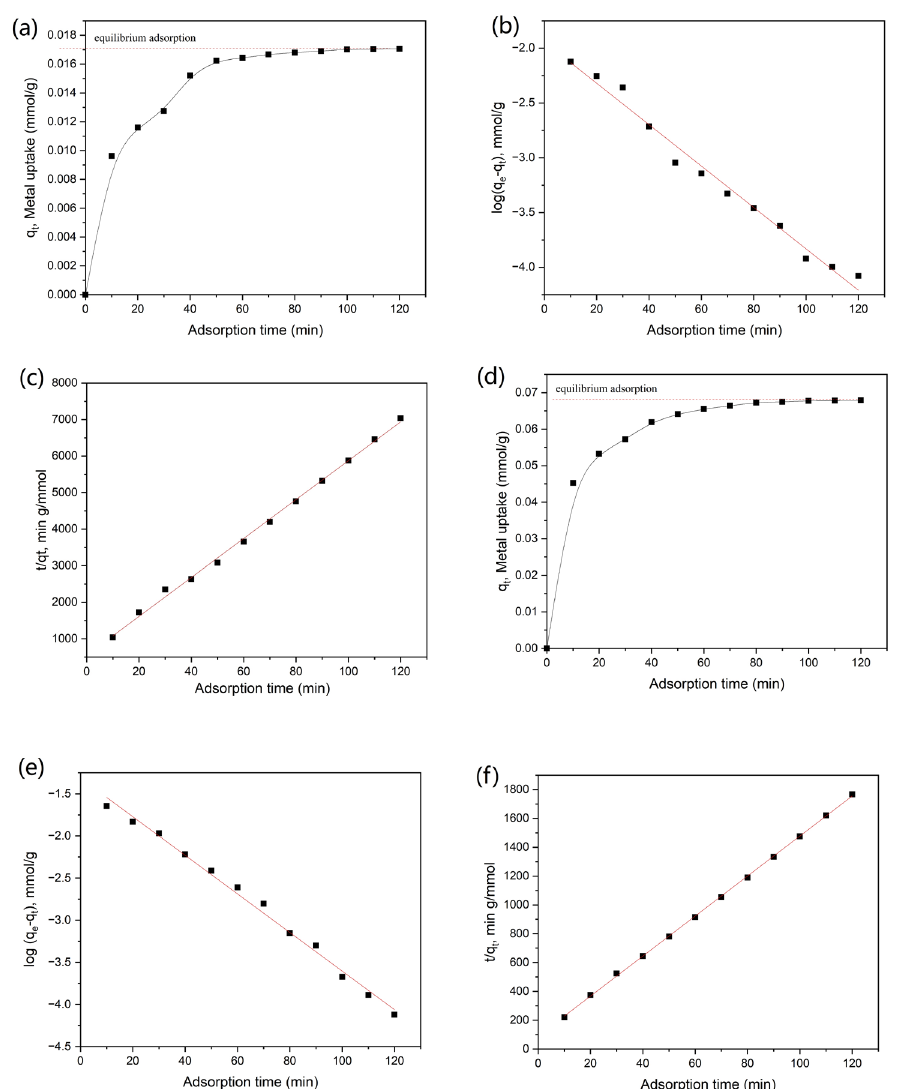
Figure 5. ( a – c ) Adsorption of Pb(II) with AC by contact time ( a ), pseudo-first-order kinetics ( b ) and pseudo-second-order ( c ) kinetics mode; ( d – f ) adsorption of Cr(VI) with AC by contact time ( d ), pseudo-first-order kinetics ( e ) and pseudo-second-order ( f ) kinetics mode.